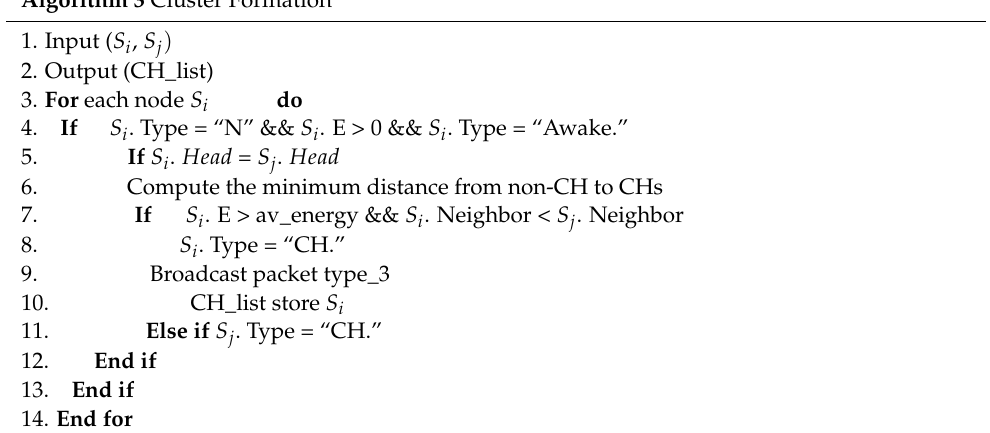
Algorithm 3 Cluster